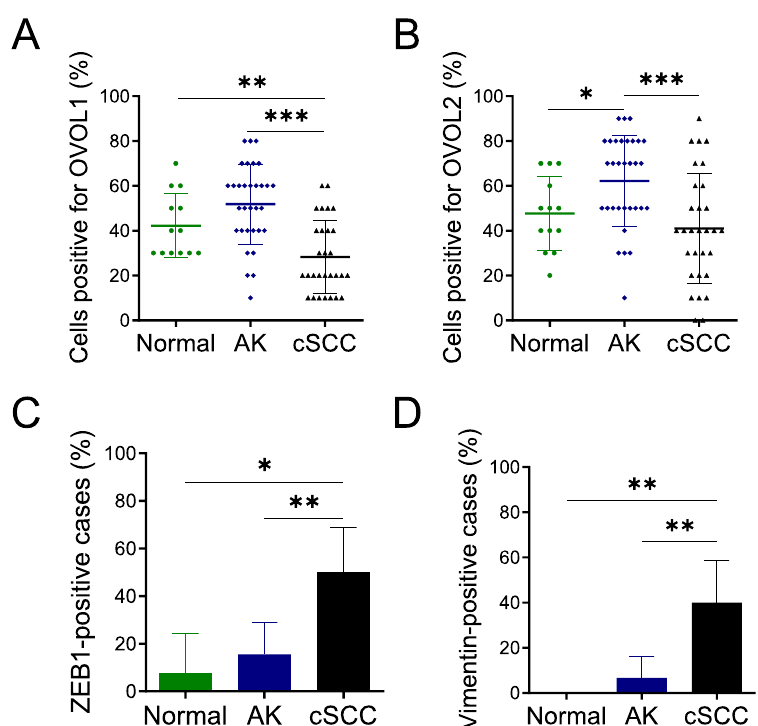
Figure 2. OVOL1, OVOL2, ZEB1, and vimentin exhibit opposite protein expression patterns between AK and cSCC. ( A–D ) OVOL1, OVOL2, ZEB1, and vimentin expression were examined in 30 AK, 30 cSCC, and 13 perilesional normal skins. (A) The percentage of cells positive for OVOL1 and (B) the percentage of cells positive for OVOL2. Dots in the bars in ( A ) and ( B ) represent each clinical sample. (C) The percentage of ZEB1-positive patient samples. Samples were considered positive for ZEB1 when nuclear expression was observed in more than 5% of tumor cells. (D) The percentage of vimentin-positive patient samples. Samples were considered positive for vimentin when expression was observed in more than 10% of tumor cells. Mann–Whitney U -test; error bars represent mean ± standard deviation. p -values < 0.05 were assumed to indicate a statistically significant di ff erence; * p < 0.05, ** p < 0.01, and *** p < 0.001.